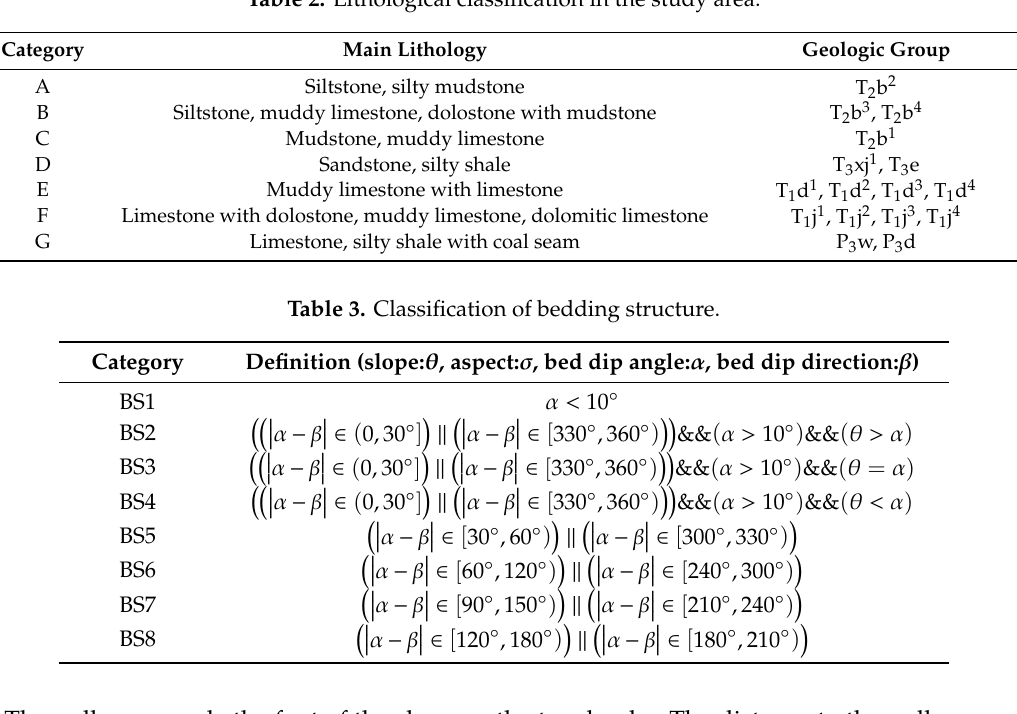
Figure 2. Landslide causal factors of the study area: ( a ) slope, ( b ) aspect, ( c ) curvature, ( d ) plan curvature, ( e ) profile curvature, ( f ) SPI, ( g ) TWI, ( h ) TRI, ( i ) lithology, ( j ) bedding structure, ( k ) distance to faults, ( l ) distance to rivers, ( m ) distance to gully.